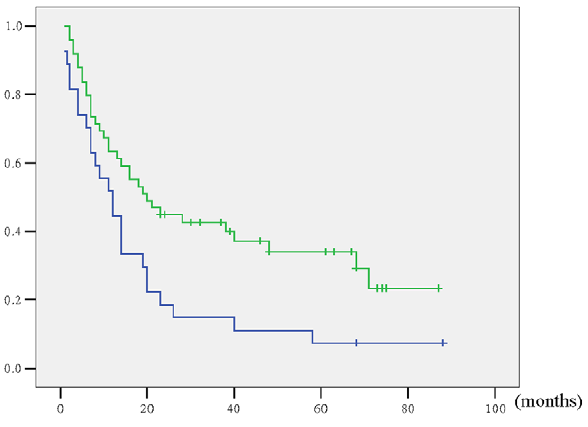
Figure 2. Actuarial survival curve according to preoperative jaundice. (With versus without jaundice: